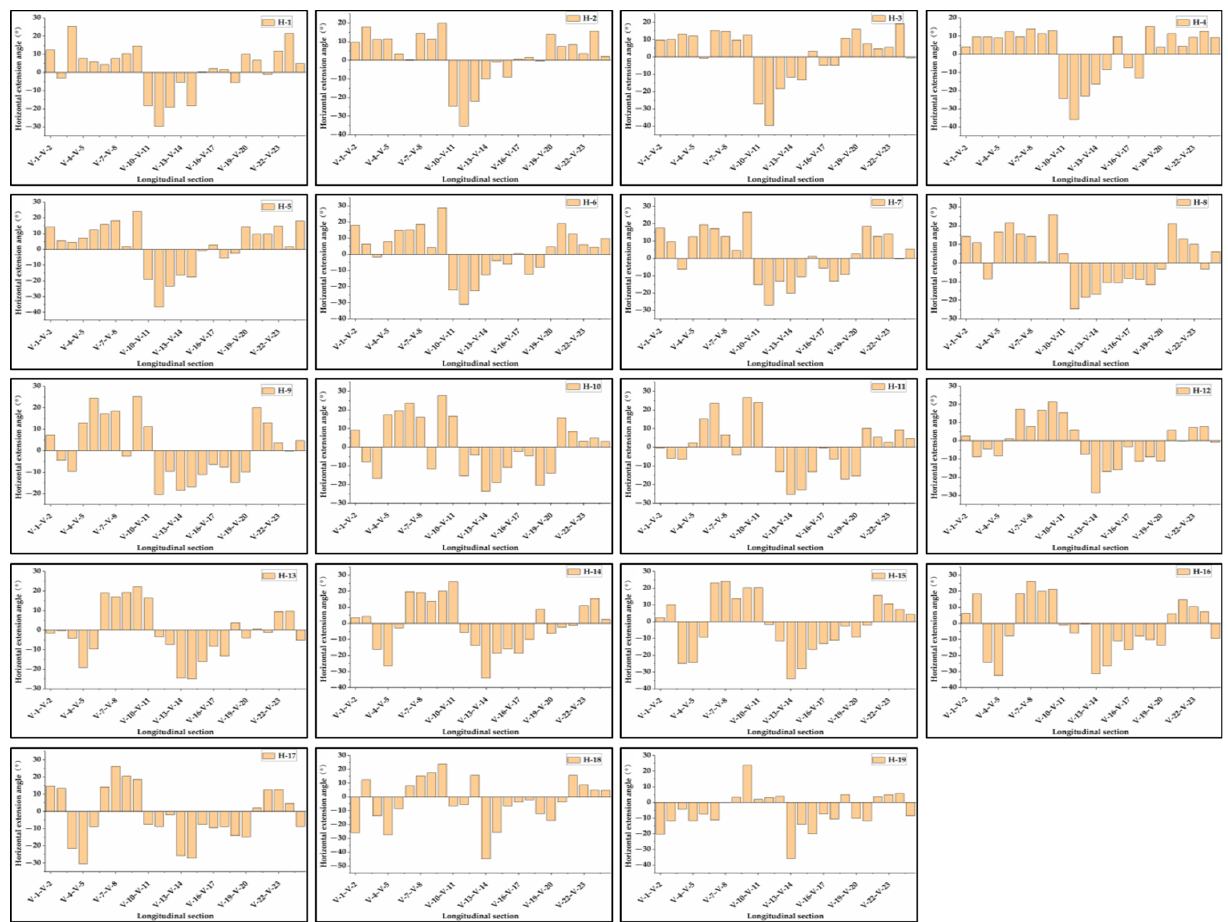
Figure 19. The horizontal extension angle of the ground fissure.